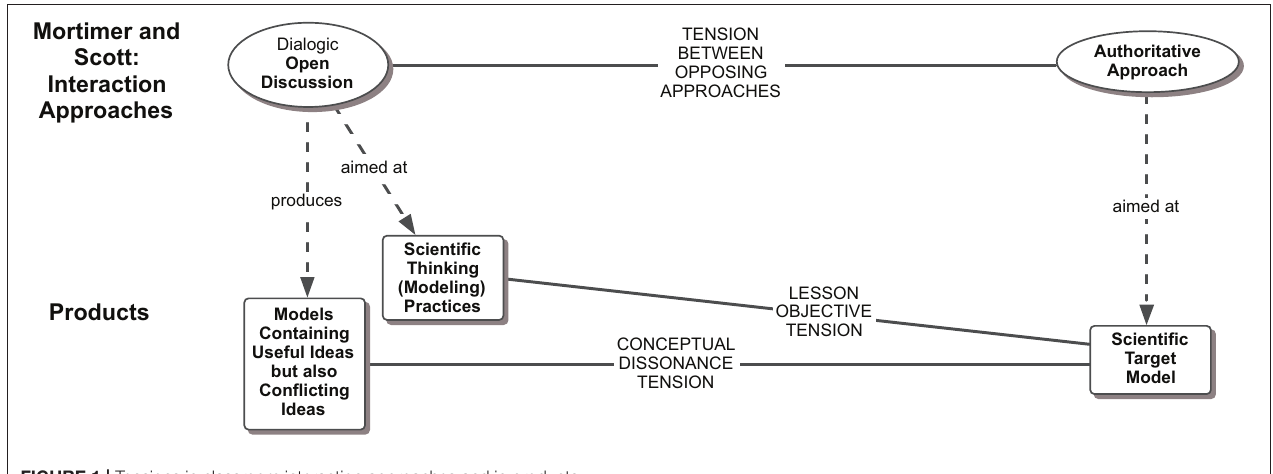
FIGURE 1 | Tensions in classroom interaction approaches and in